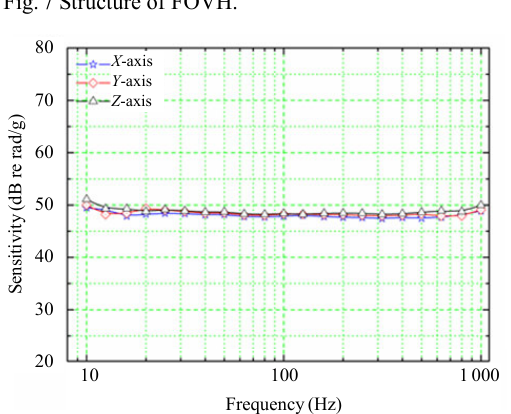
Fig. 8 Acceleration sensitivity of